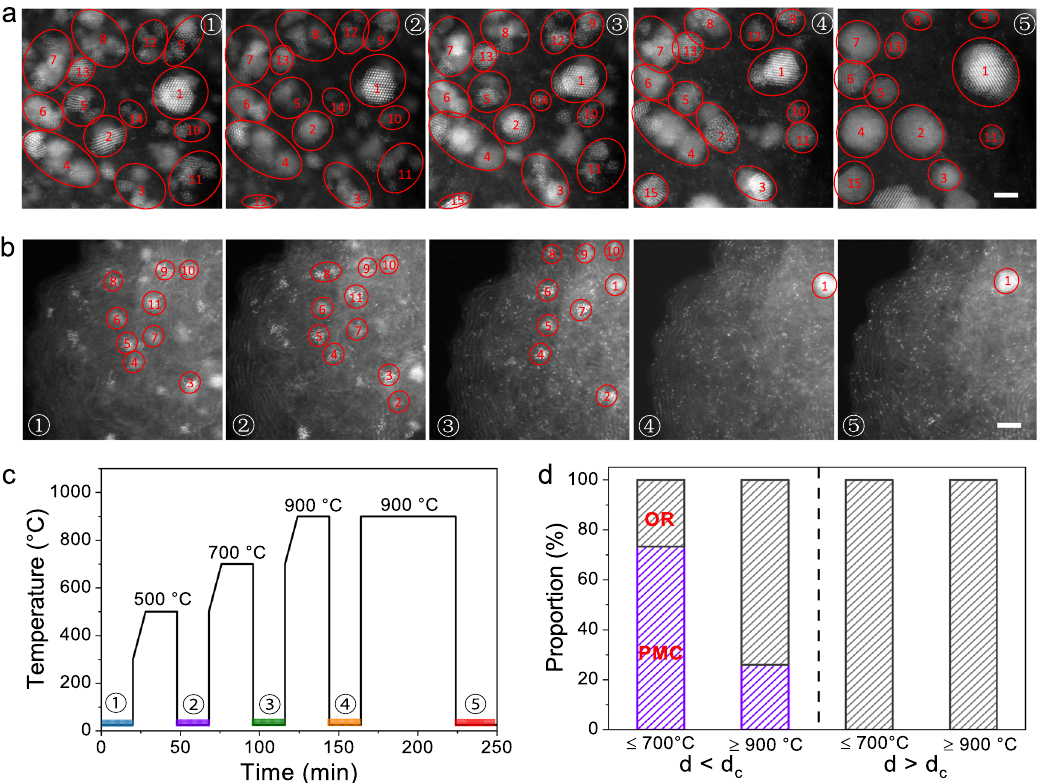
Fig. 4 In situ sintering HAADF-STEM studies. a , b In situ aberration-corrected HAADF-STEM images of 10%Pt/XC-72R ( a ) and 1%Pt/XC-72R ( b ) at different stages shown in ( c ). Scale bar, 2 nm. c Temperature-time program of the sintering protocol. HAADF-STEM observations were performed when the samples were quenched to room temperature (100 °C per second) after each stage of in situ heating. d Proportion of OR and PMC mechanisms identi fi ed for the short (10%Pt/XC-72R, d < d c ) and long (1%Pt/XC-72R, d > d c ) particle distance catalysts at the early stages ( ≤ 700 °C) and later stages ( ≥ 900 °C),